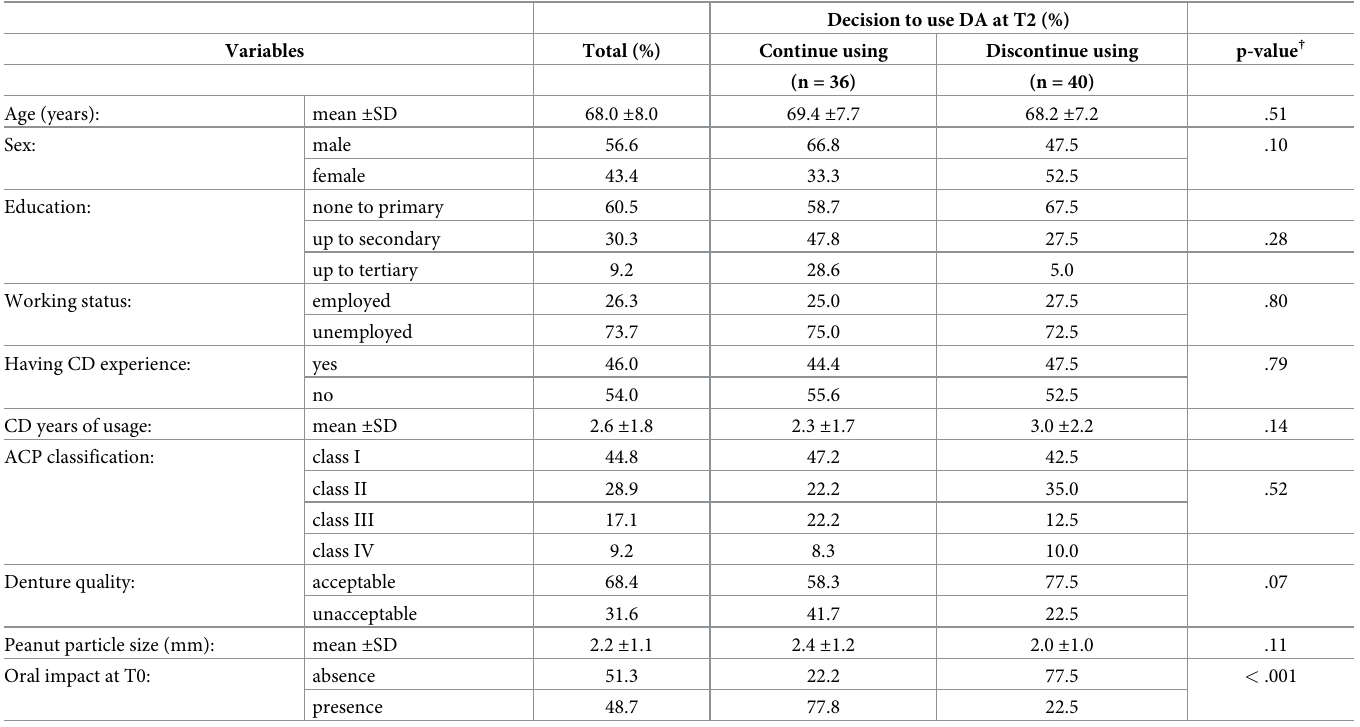
Table 1. Baseline characteristics of the participants at T0 (N =